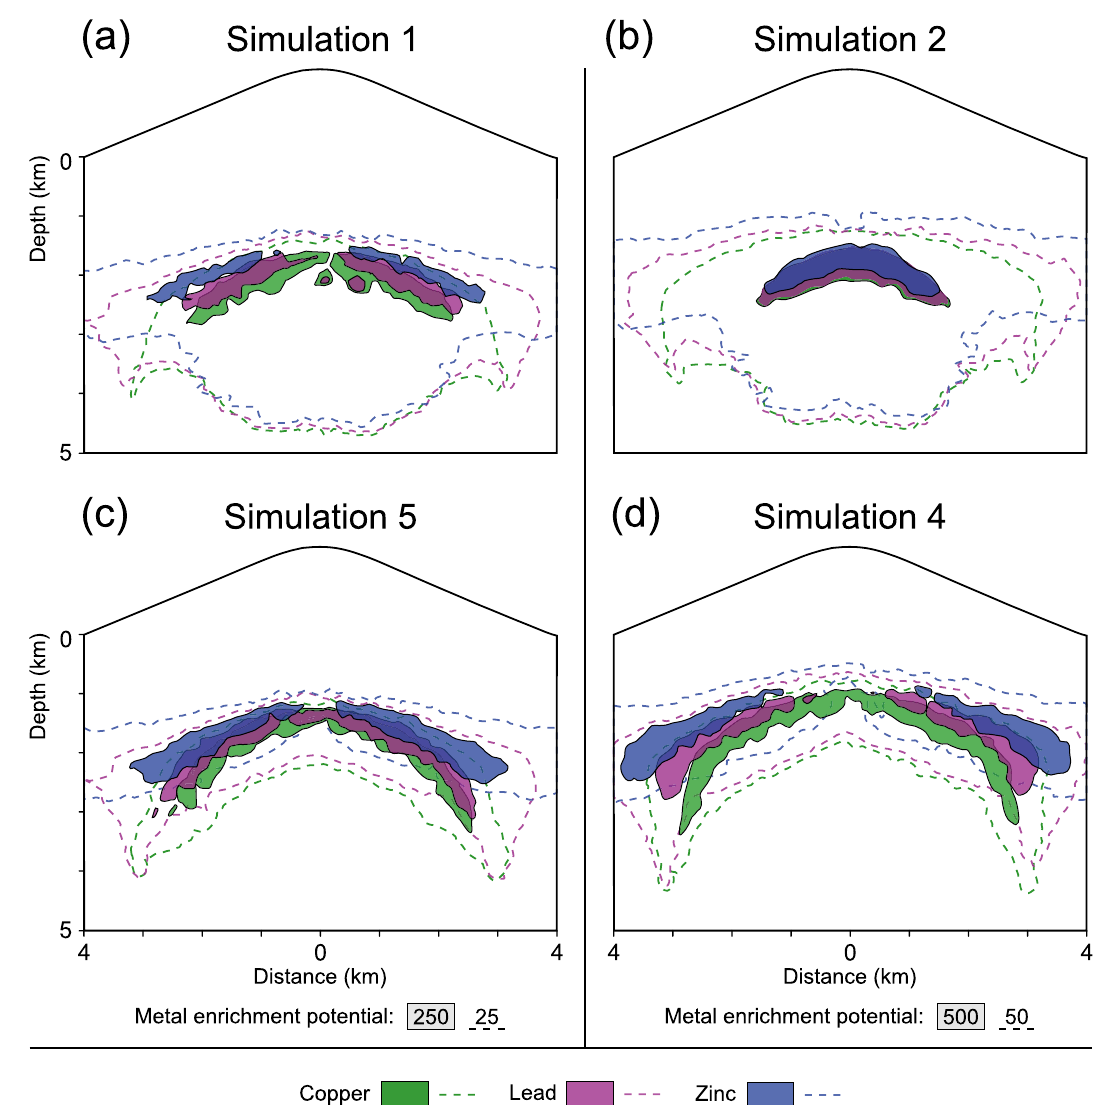
Figure 8. Modeled ore shells after 100 kyrs for simulations without ( a , b ) and with ( c , d ) remobilization. The different thresholds for metal enrichment potentials (25 vs. 50; 250 vs. 500) reflect the different fluid release rates controlled by the different reservoir volumes used in the respective